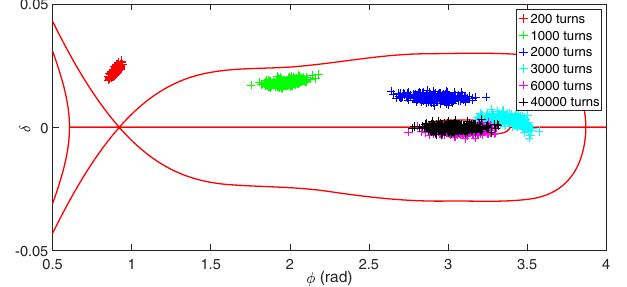
FIG. 12. Particle distribution in the longitudinal plane, in which the beam is injected at dt ¼ − 2 . 3 ns, dp ¼ 0 . 03 , and it can be merged to the center of the main